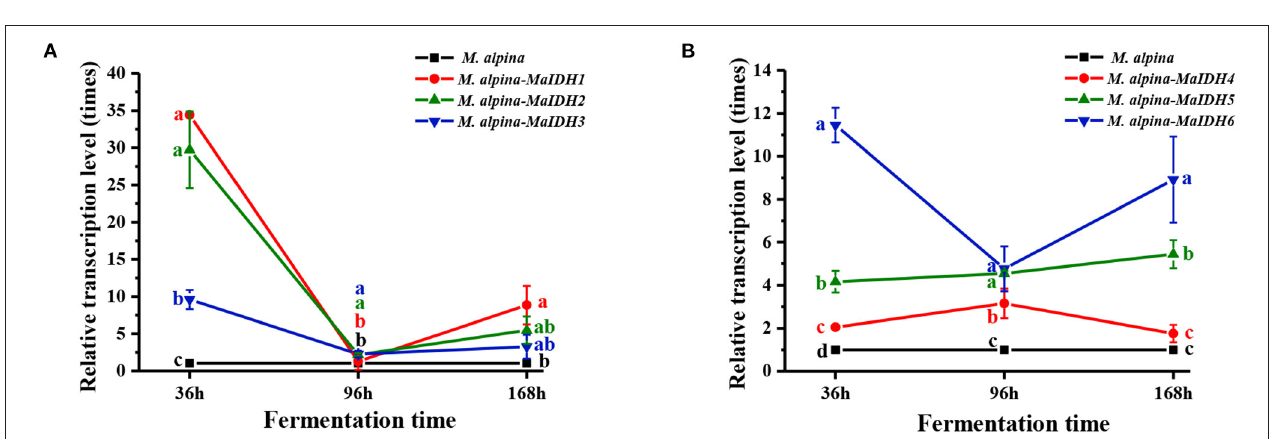
FIGURE 4 | Transcriptional levels of various MaIDHs recombinant strains of M. alpina at different time points (36, 96, and 168h). (A) Transcriptional levels of NAD + -MaIDHs, (B) transcriptional levels of NADP + -MaIDHs.